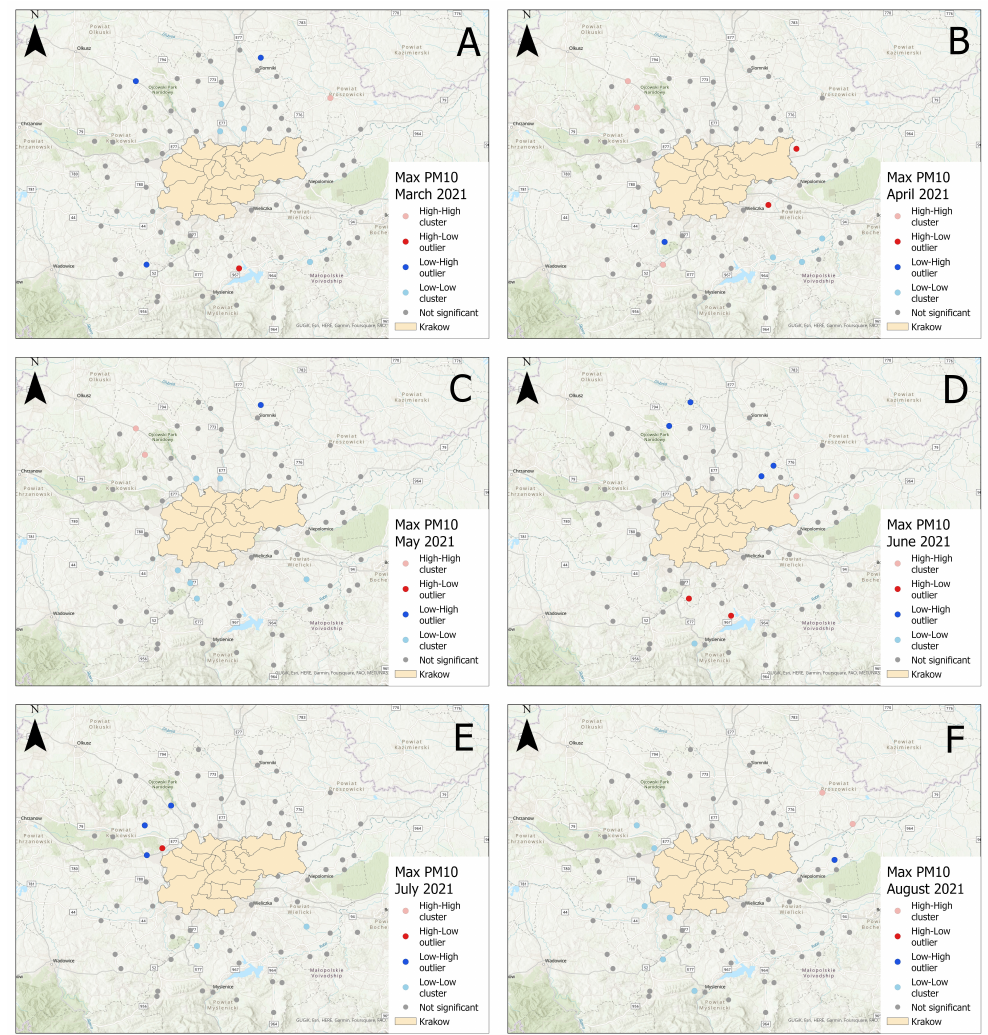
Figure 11. The spatial associations for monthly maximum PM10 concentrations showing high-high and low-low clusters and high-low and low-high outliers using Local Moran’s I. The maps illustrate clustering in March ( A ), April ( B ), May ( C ), June ( D ), July ( E ), and August 2021 ( F